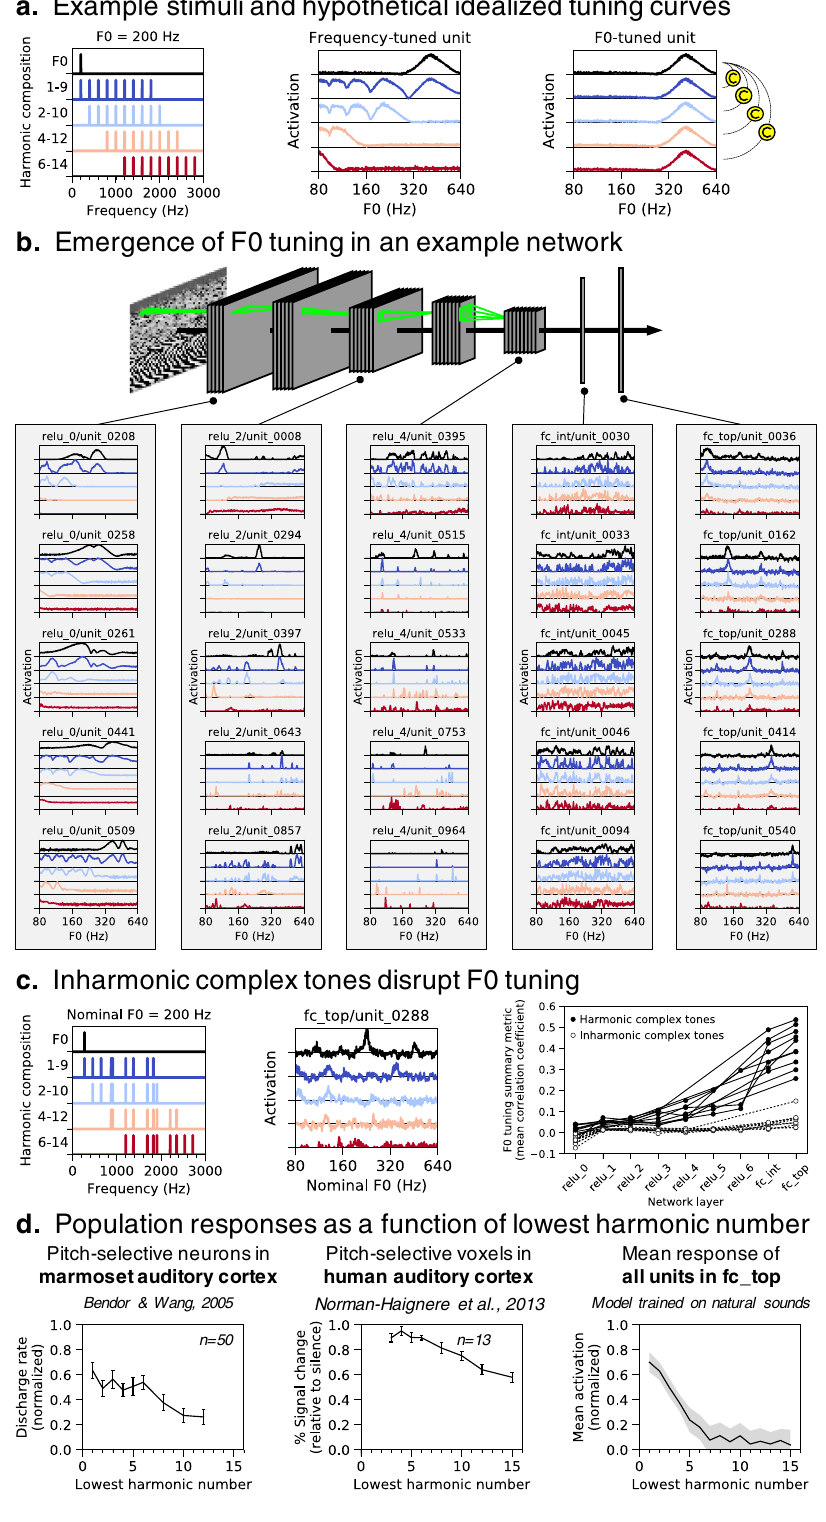
strongly when stimuli contained low-numbered harmonics (Fig. 9d, right; main effect of lowest harmonic number on mean activation, F (1.99,17.91) = 134.69, p < 0.001, η 2